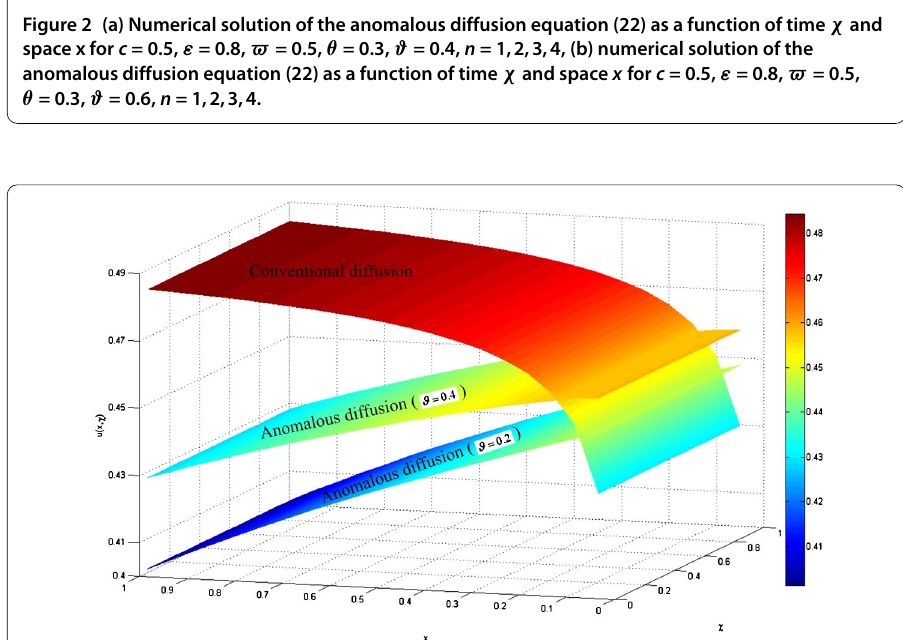
Figure 3 Comparisons between conventional diffusion with c = 0.5, ε = 0.8 and anomalous diffusion with c = 0.5, ε = 0.8, (cid:4) = 0.5, θ = 0.3, ϑ = 0.2,0.4, n =